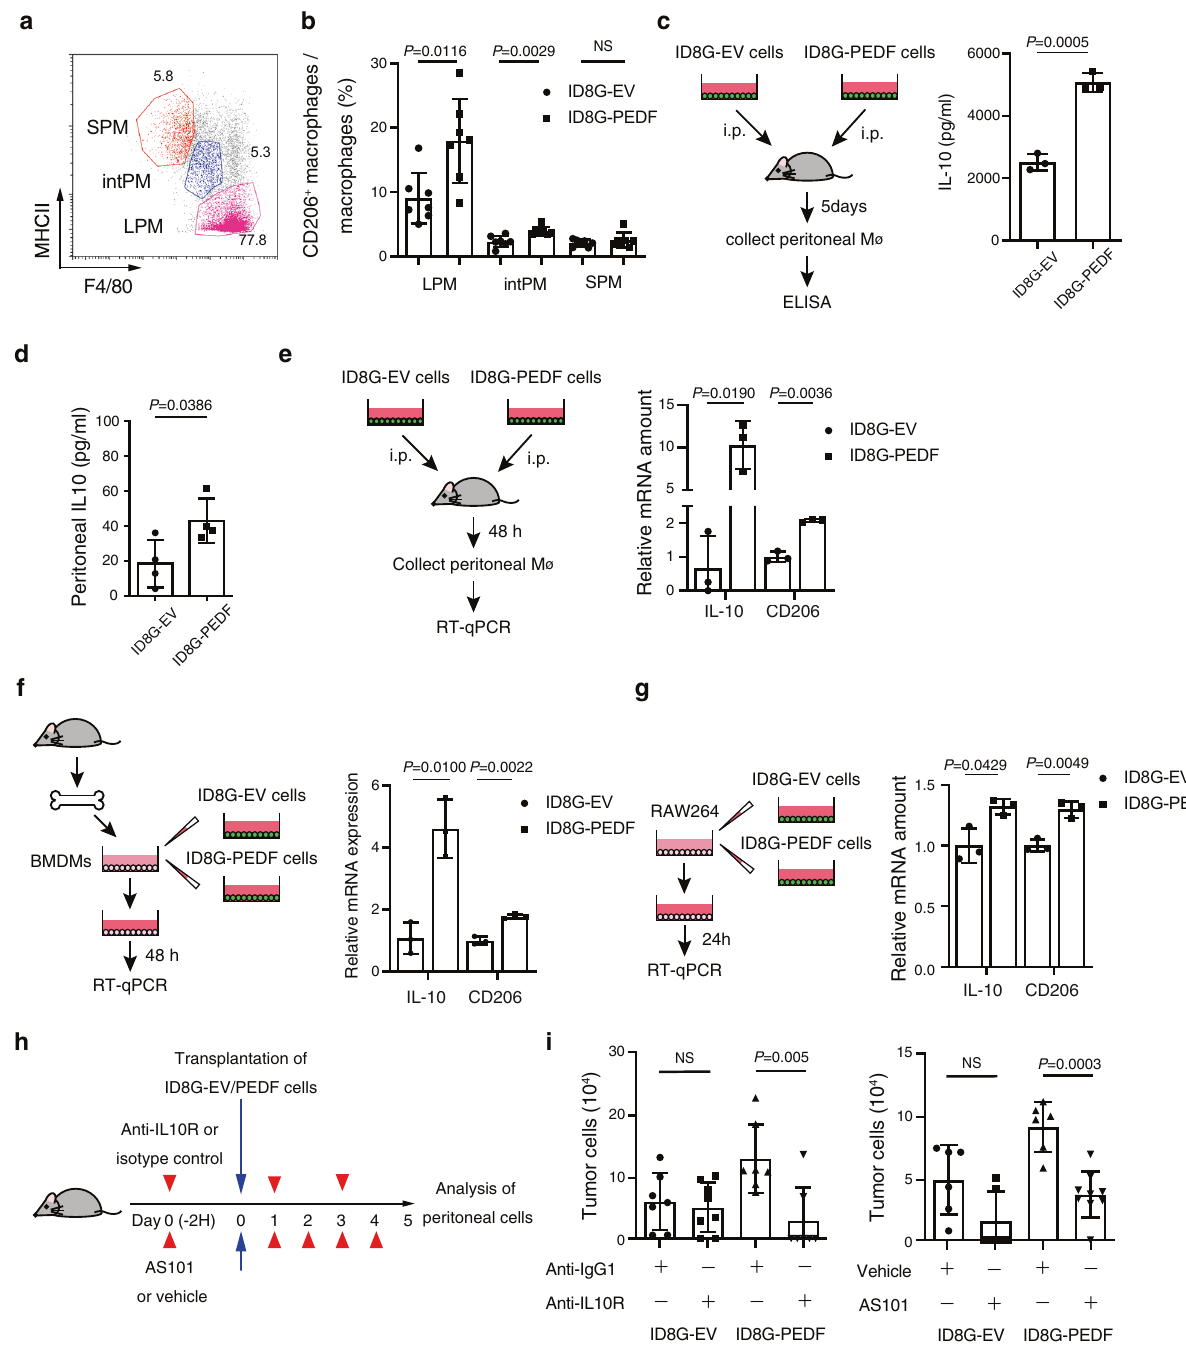
Fig. 5 PEDF-induced immunosuppressive macrophages contribute to tumor cell survival in the mouse peritoneal cavity. a Flow cytometric analysis of peritoneal myeloid cells (CD45 + CD11b + cells) 5 days after intraperitoneal injection of OC cells. LPMs were subsequently gated as F4/80 + MHC II – (pink), intPM as F4/80 int MHC II int (blue), and SPMs as F4/80 - MHC II + (red). b Percentage of CD206 + macrophages among LPMs, intPMs, and SPMs in the peritoneal cavity of C57BL/6 J mice at 5 days after i.p injection of ID8G-EV or ID8G-PEDF cells ( n = 7 mice). c IL-10 ELISA from peritoneal macrophages of C57BL/6 J mice injected with ID8G-EV or ID8G-PEDF cells ( n = 3). d IL-10 concentration in peritoneal wash fl uid collected at 5 days after OC cell transplantation ( n = 4 mice each). e RT-qPCR analysis of IL-10 and CD206 mRNAs in peritoneal CD45 + CD11b + F4/80 + macrophages (Mø) isolated at 48 h after i.p. injection of C57BL/6 J mice with ID8G-EV or ID8G-PEDF cells ( n = 3 mice each). f RT-qPCR analysis of IL-10 and CD206 mRNAs in BMDMs isolated from C57BL/6J mice and treated with conditioned medium of ID8G-EV or ID8G-PEDF cells for 48 h ( n = 3 replicates from one of two independent experiments). g RT-qPCR analysis of IL-10 and CD206 mRNAs in RAW 264 cells treated with conditioned medium of ID8G-EV or ID8G-PEDF cells for 24 h ( n = 3 replicates from one of two independent experiments). h C57BL/6 J mice were injected i.p. with ID8G-EV or ID8G-PEDF cells after the onset of repeated i.v. administration of antibodies to IL-10R (or control IgG) or AS101 (or vehicle). i Flow cytometric analysis of the number of GFP + (tumor) cells in the peritoneal cavity at 5 days after ID8G-EV or ID8G-PEDF cell injection in mice treated with anti – IL-10R ( n = 7 or 8) or control IgG ( n = 7 each) or with AS101 ( n = 6 or 9) or vehicle ( n = 6 each) as in h . All data are means ± SD and were analyzed by unpaired t test with Welch ’ s